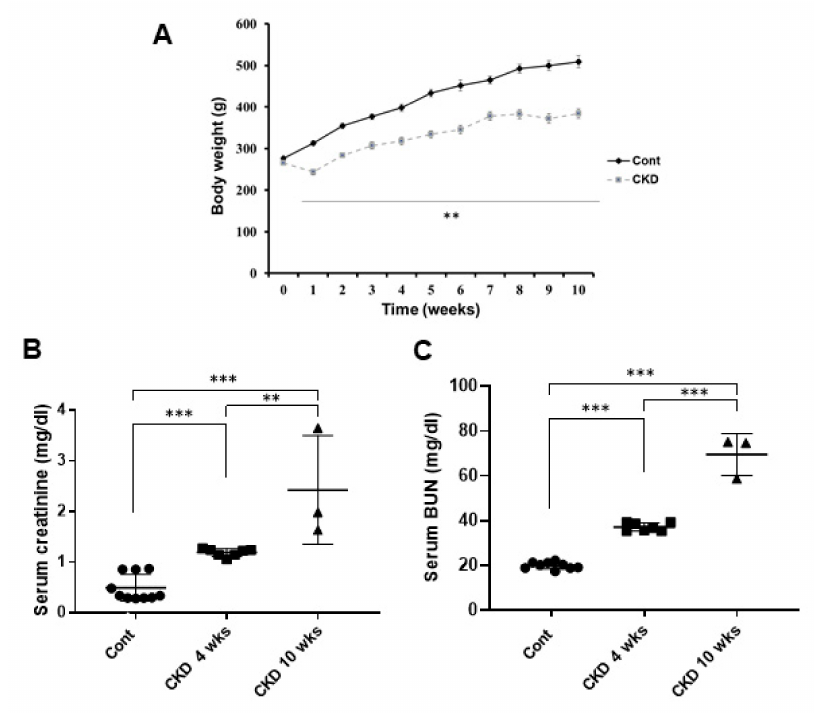
Figure 1. Body weight and blood analysis of CKD and wild-type rat. The body weights of CKD rats were significantly reduced compared with the wild-type group ( A ). Serum creatinine and BUN levels were increased in CKD rat animal model more than in the wild-type ( B , C ). Data are presented as means ± standard errors of the mean. ** p < 0.01, *** p < 0.001, one-way analysis of